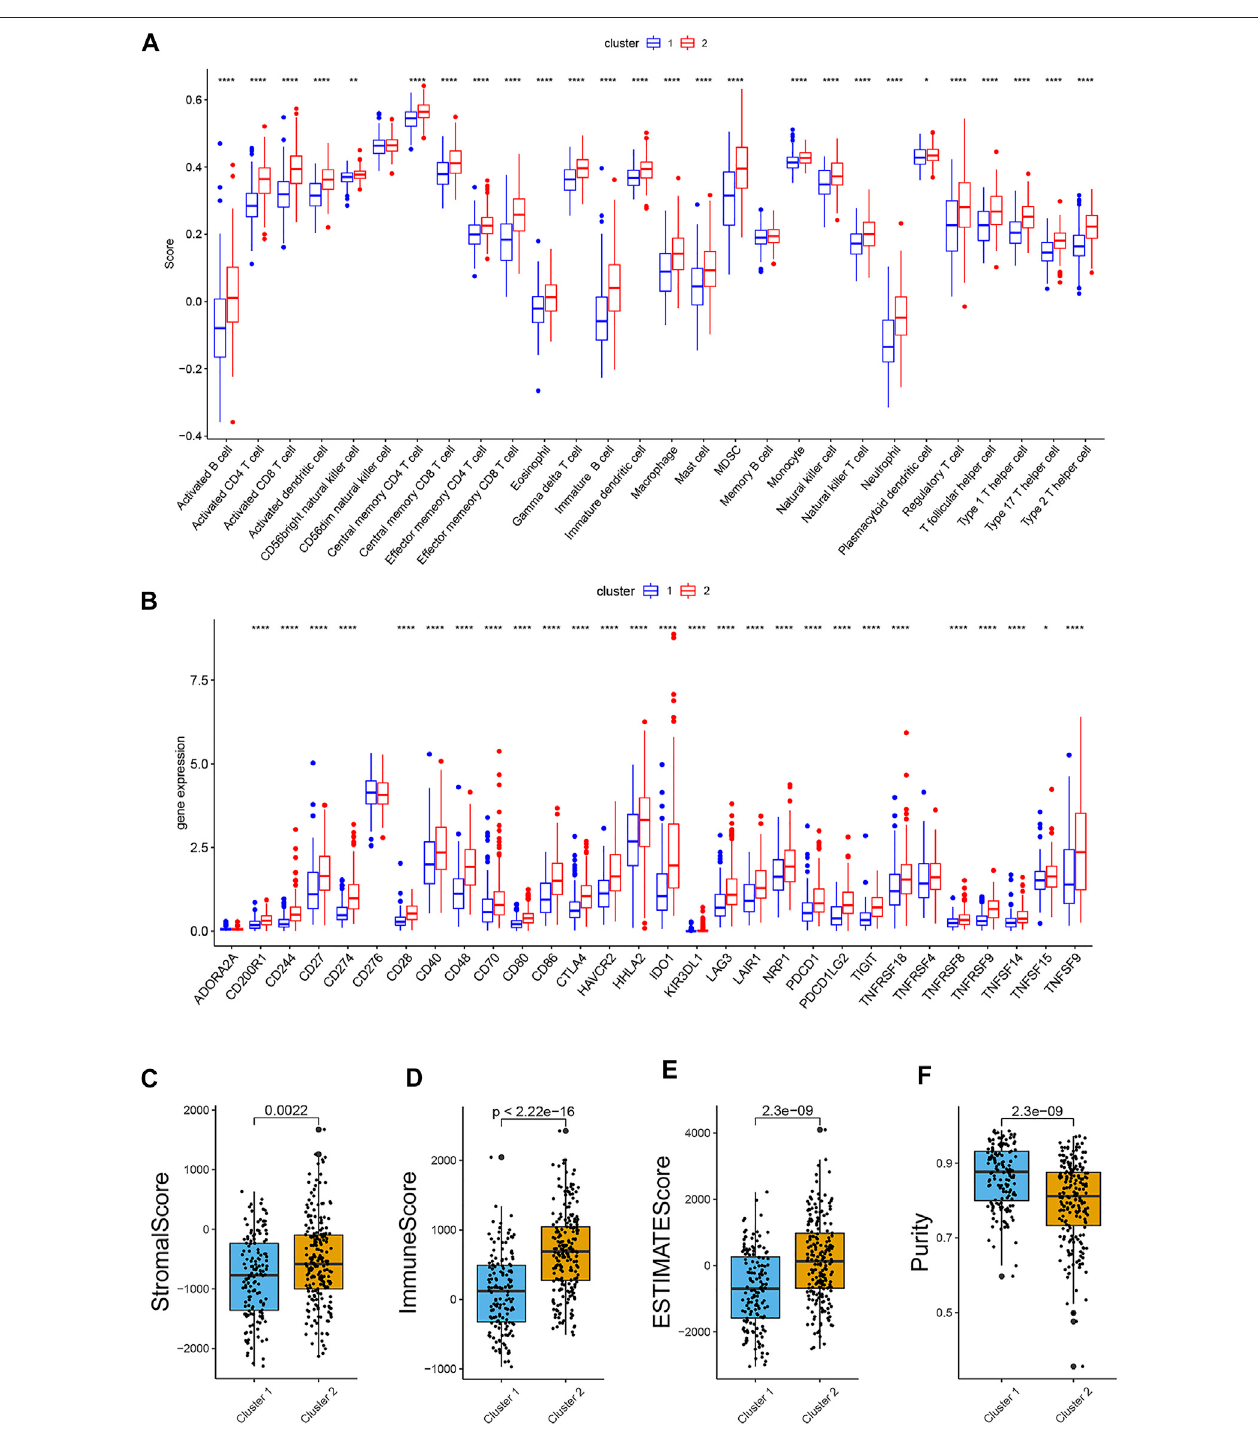
FIGURE 3 | Comparison of immune in fi ltration, expression level of immune checkpoint and ESTIMATE scores in two groups. (A). Boxplot of the difference of immunein fi ltrationcellsintwoclusters; (B). Boxplotoftheexpression levelofimmunecheckpointintwoclusters; (C). Stromalscore; (D). Immune score; (E) .ESTIMATE score; (F) . Purity. ( p < 0.05 *, p < 0.01 **, p < 0.001 ***, p < 0.0001 ****).